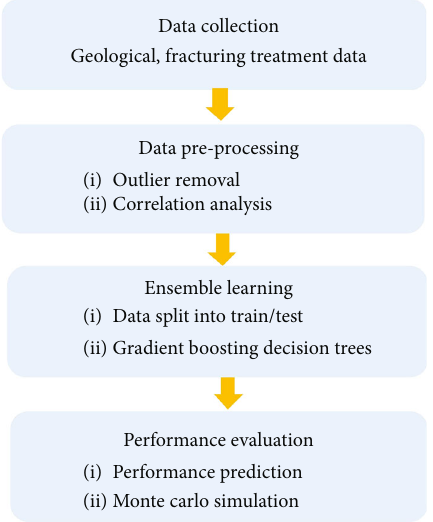
Figure 1: Work fl ow of HF performance